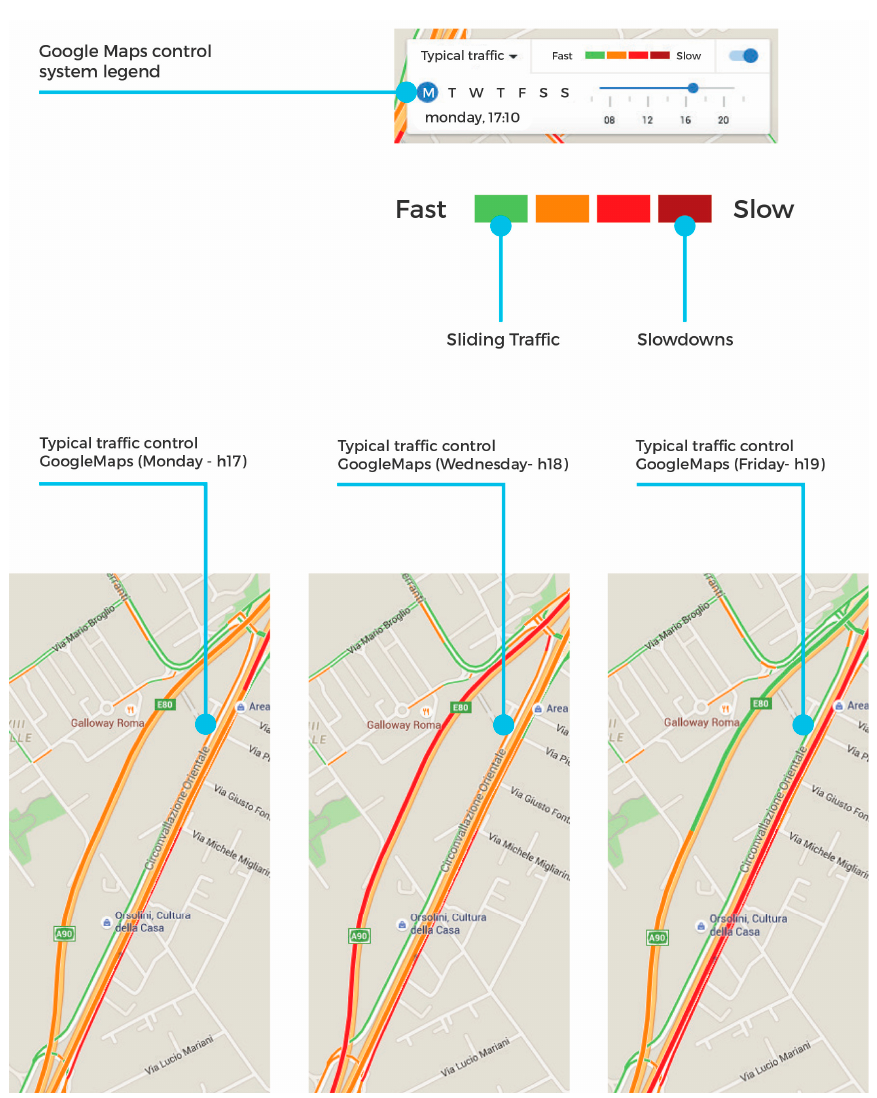
Figure 4. Traffic flow tool in the area of interest available through Google Maps application (image by Rosario Di Vincenzo).